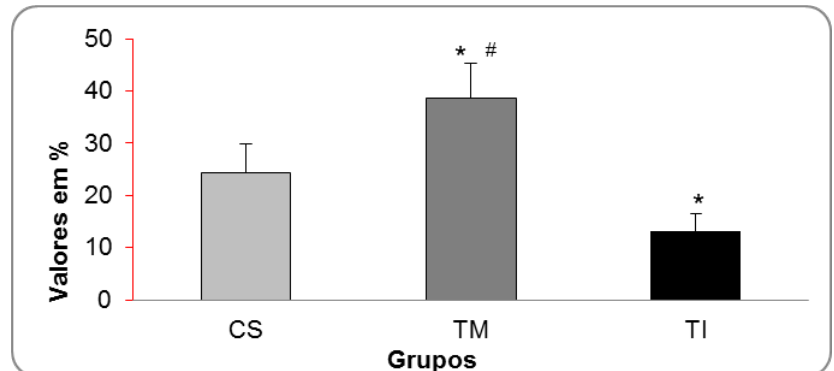
Figura 2. Taxa de fagocitose liberada por macrófagos alveolares em ratos adultos, após a realização do programa de TF . Dados em média e desvio padrão. ANOVA, post-hoc Turkey (p<0,001). * - Diferença entre grupos treinos e controle; # - Diferença entre os grupos TM e